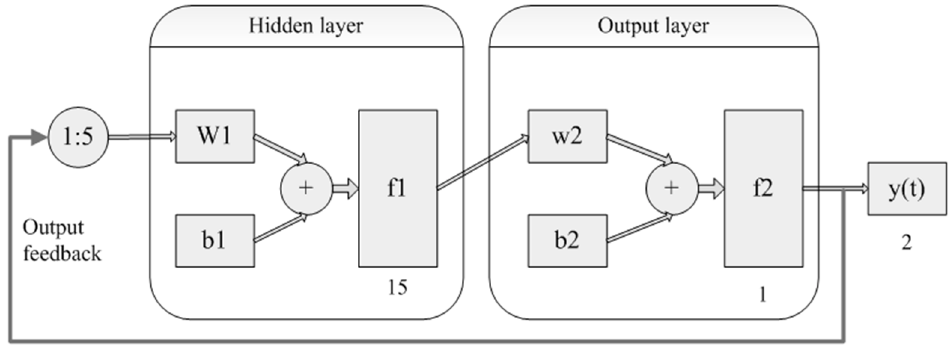
Figure 8. Nonlinear auto-regressive (NAR) neural network structure.